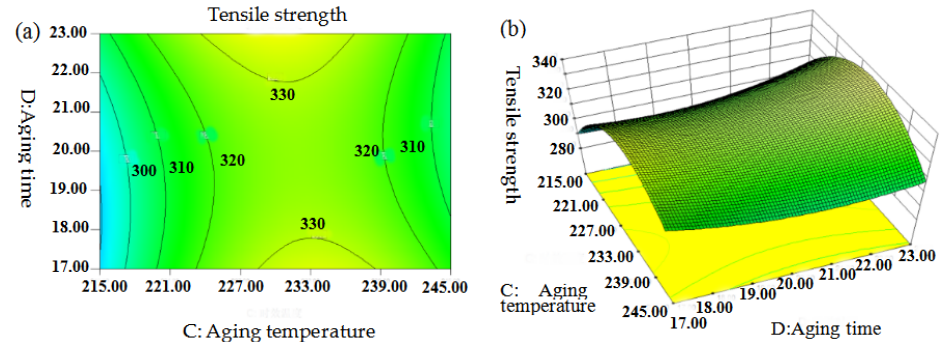
Figure 14. Interaction between ageing time and ageing temperature versus the tensile strength. ( a ) contour map; ( b ) surface response map.